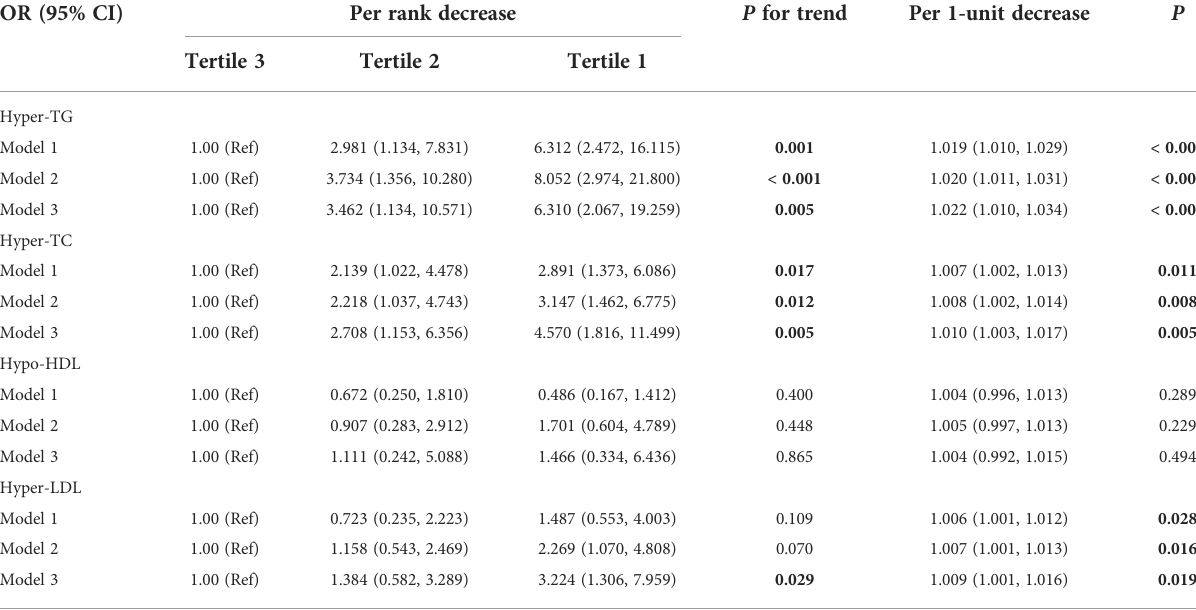
TABLE 4 Logistic regression analysis of the association between serum Mternl levels and adverse lipid pro fi le.